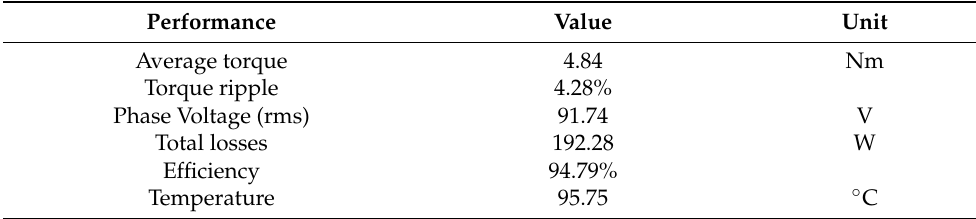
Table 5. 3D machine performance.